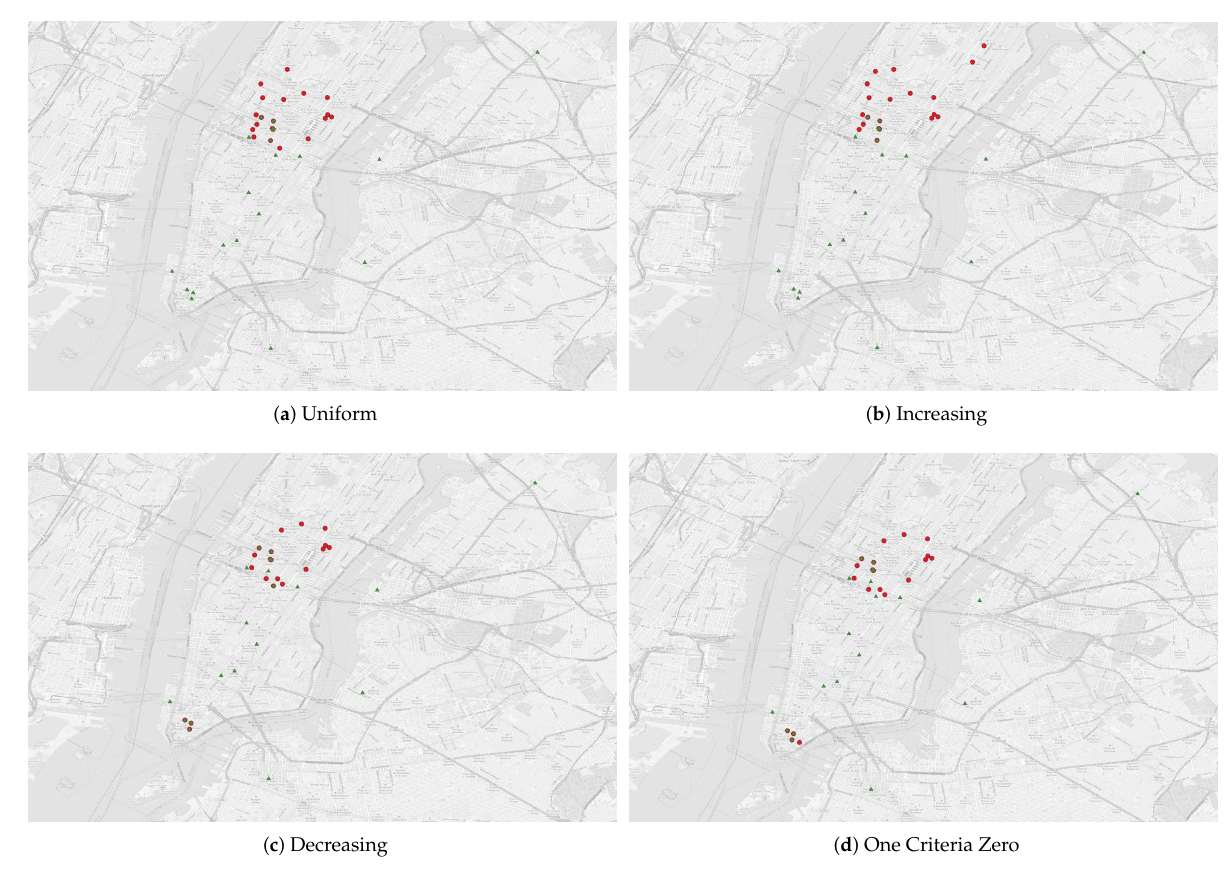
Figure 9. Manual weight assignments (ground truth convenience stores (green triangles) and AHP/TOPSIS convenience stores (red